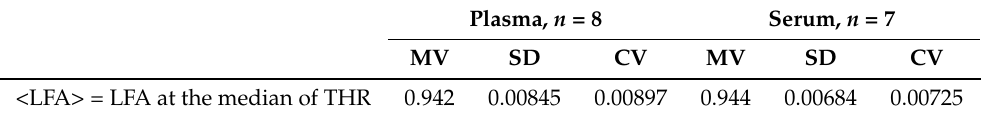
Table 3. Mean value (MV), standard deviation (SD), and coefficient of variation (CV = MV/SD) of <LFA>. Results for RBCs suspended in plasma and serum. LFA = THR long /THR wide . Plasma, n =